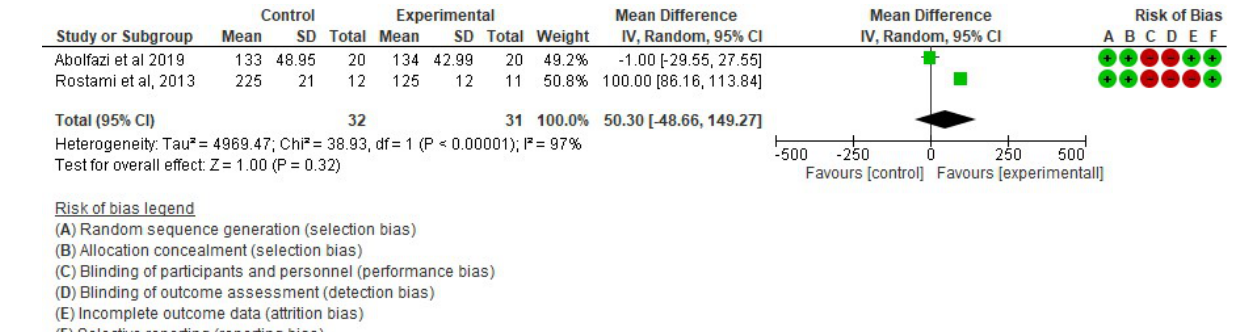
Figure 4. Effect of Mirror Therapy as Measured with MMDT [37,39].